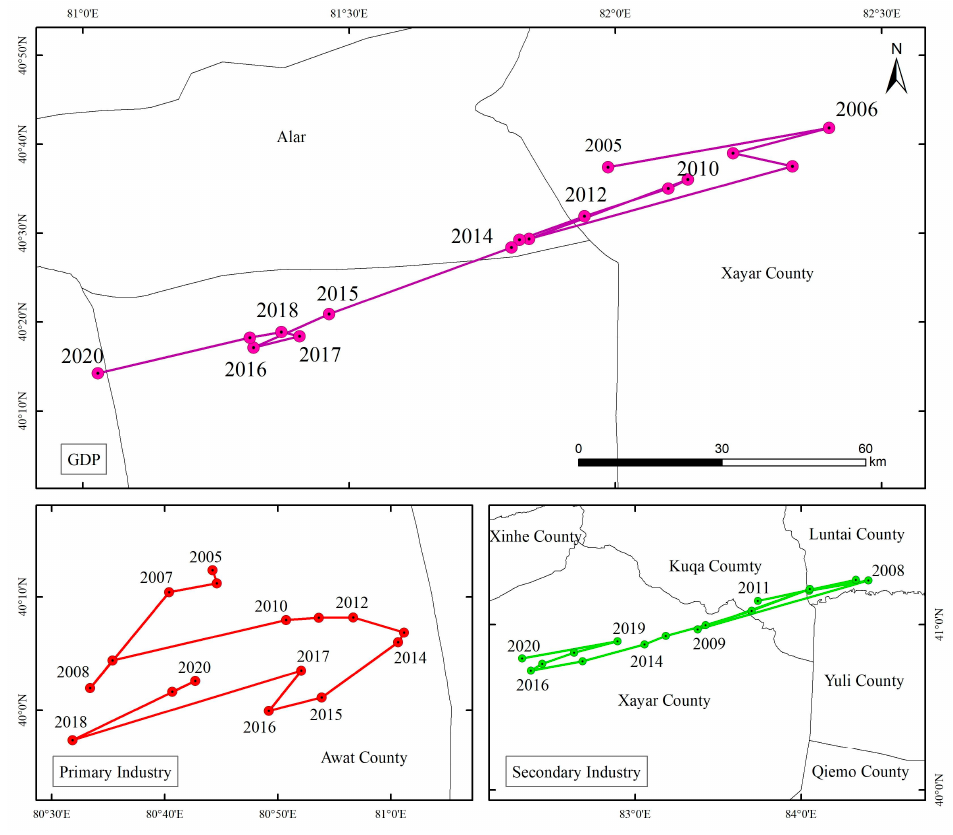
Figure 5. Evolutionary track of the GDP CG in the Tarim River Basin. Table 2. GDP, center of gravity coordinates, and migration distance in the Tarim River Basin.